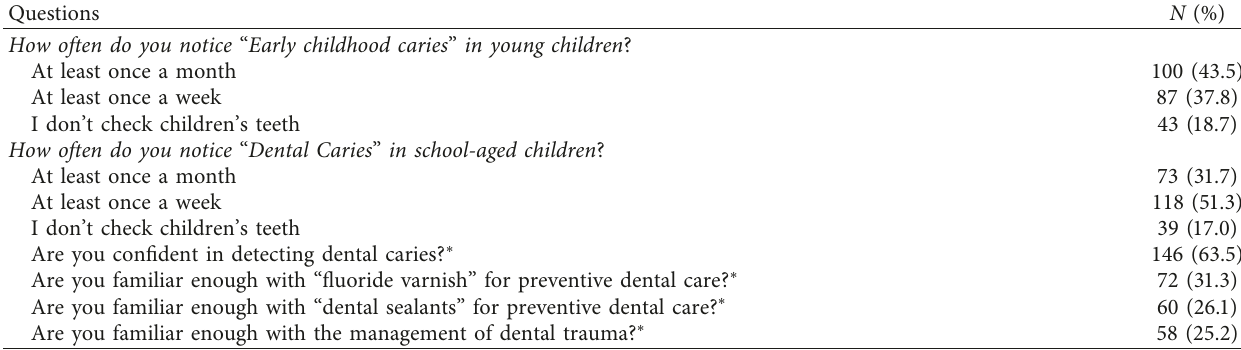
Table 4: Experience of the participants with dental problems and dental care.